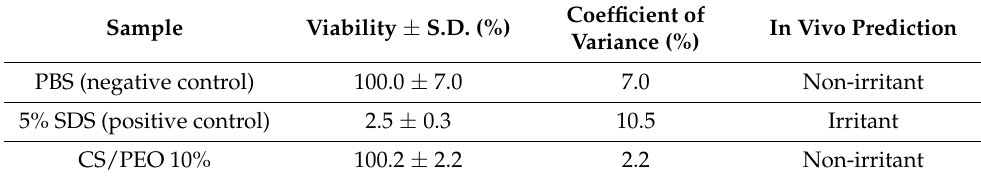
Table 1. Data from EpiDerm Skin Irritation assay (mean ± S.D.; n =